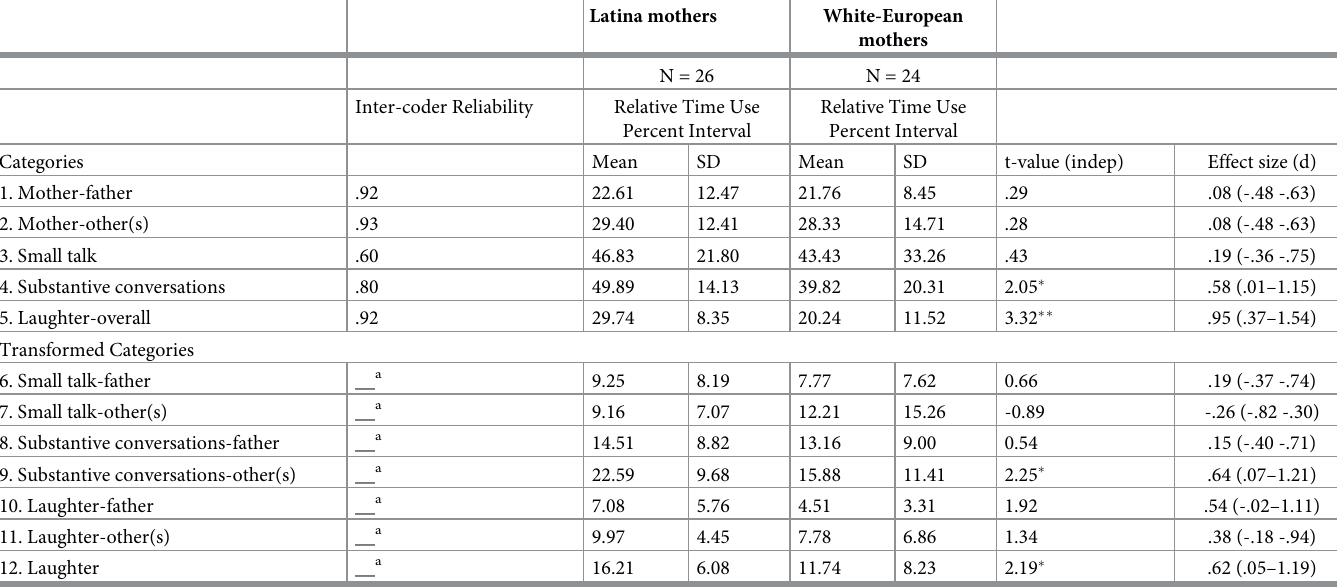
Table 2. Conversation style variables for latina and white-european mothers: Descriptive statistics and